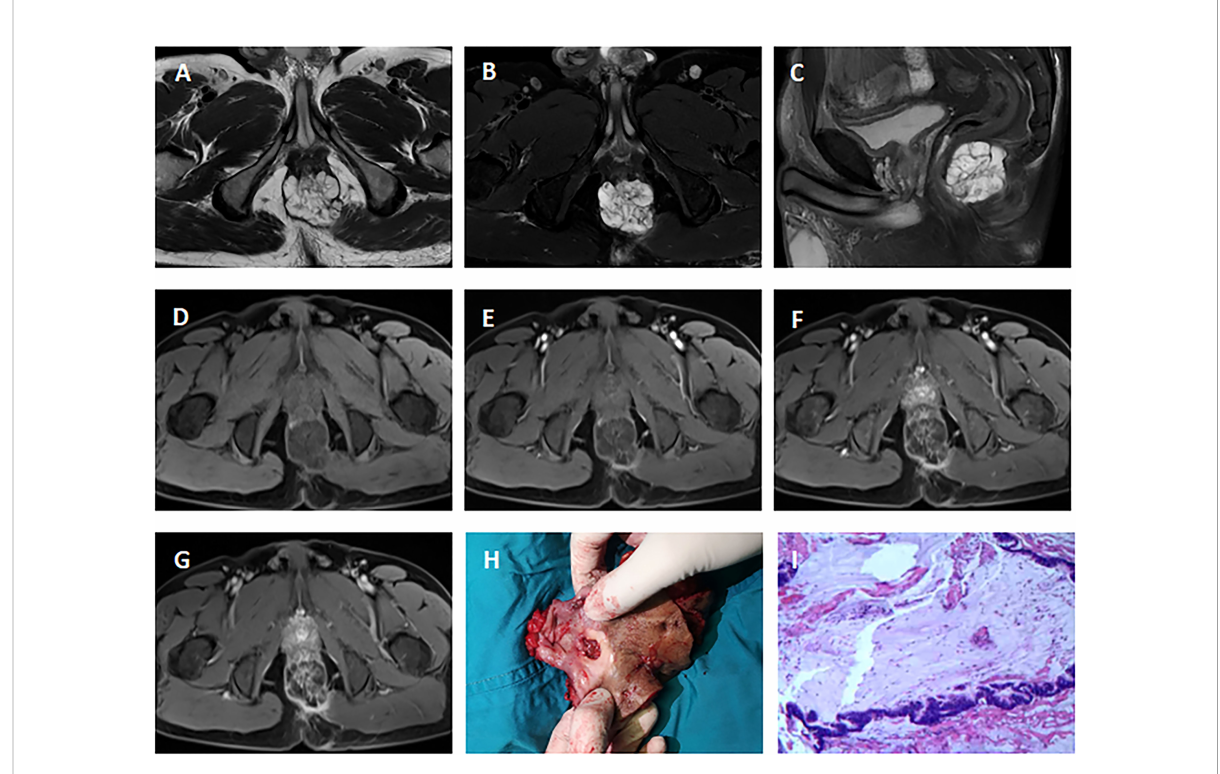
FIGURE 1 MRI of a 51-year-old man with mucinous adenocarcinoma. (A) : Axial T2-weighted image; (B) : Axial fat-suppressed T2-weighted image; (C) : Sagittal fat-suppressed T2-weighted image; (D – G) : Axial dynamic contrast-enhanced images. The tumor grew across the midline. This lesion was multiloculated, cauli fl ower-like, markedly hyperintense on fat-suppressed T2-weighted image. Axial dynamic contrast-enhanced images showed progressive heterogeneous enhancement, and the boundary of the enhanced region was clear. (H) : Clinical photograph showed the abdominoperineal resection specimen (the proximal intestinal canal was cut up). (I) : The tumor was rich in mucus (hematoxylin and eosin staining; original magni fi cation,